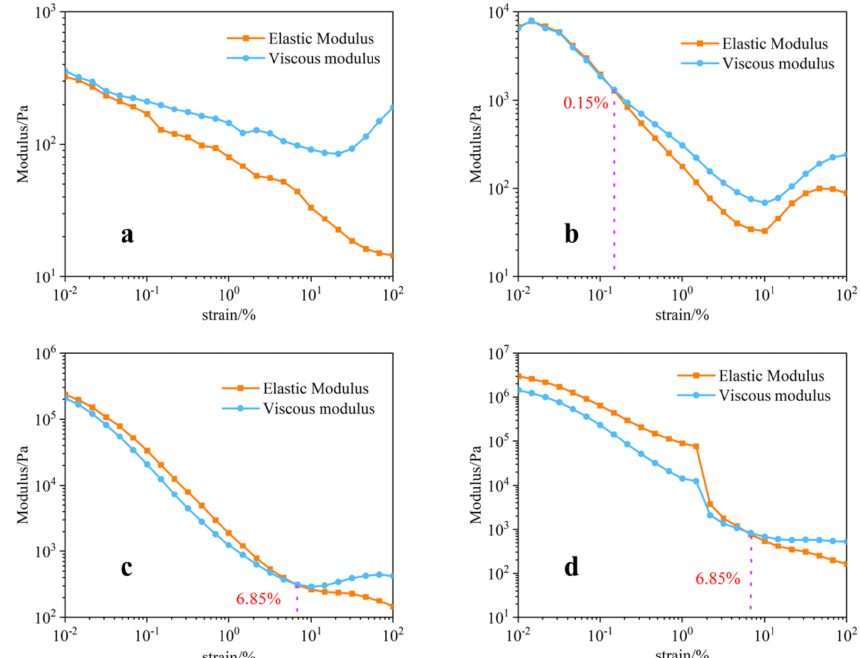
Figure 4. Elastic modulus and viscous modulus images of four samples with different solid contents: ( a ) image of 80% sample slurry; ( b ) image of 85% sample slurry; ( c ) image of 90% sample slurry; ( d ) image of 91% sample slurry.